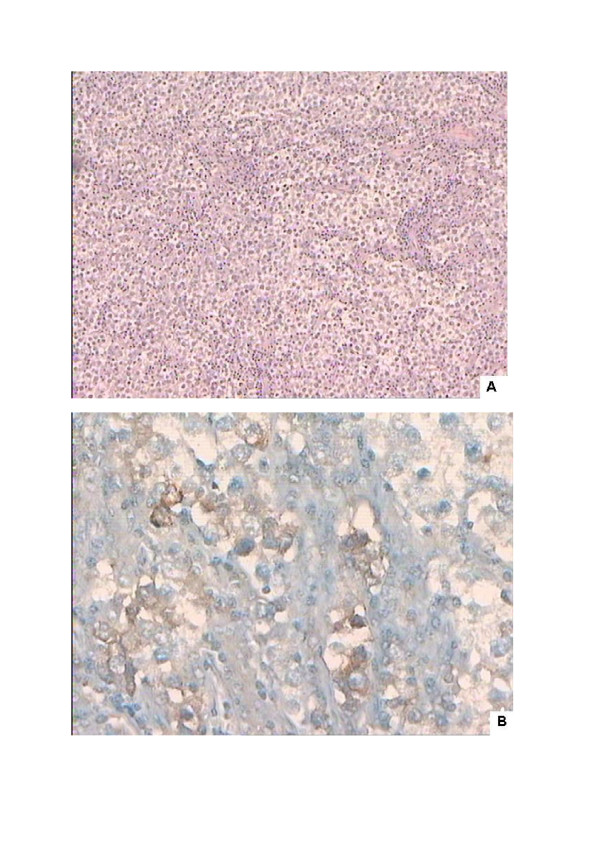
A. Testicular seminoma: Uniform tumor cells with abundant clear cytoplasm and centrally located nucleus. Tumor nests are outlined by fibrous bands infiltrated by lymphocytes. (medium power magnification). 4B: Rare cells stain positive for β-hCG (high power magnification).